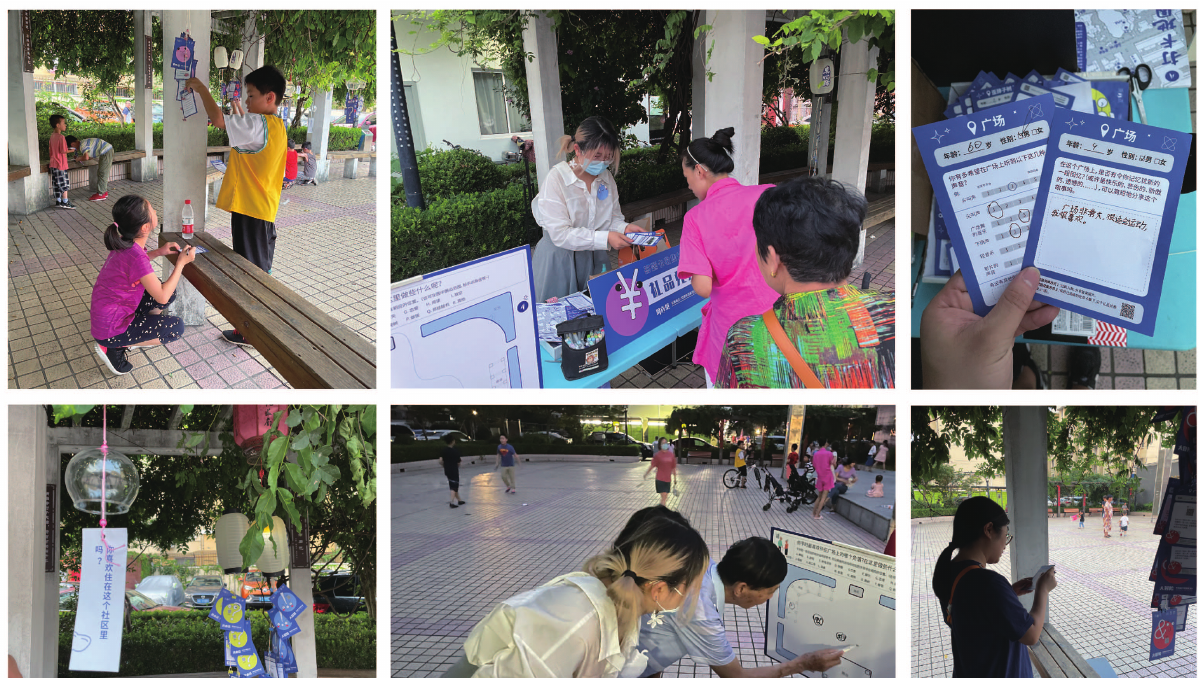
Figure 2Figure 2. Community participatory research